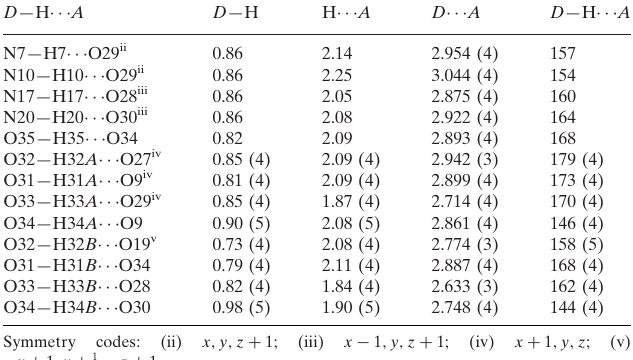
Hydrogen-bond geometry (A˚ , (cid:3)